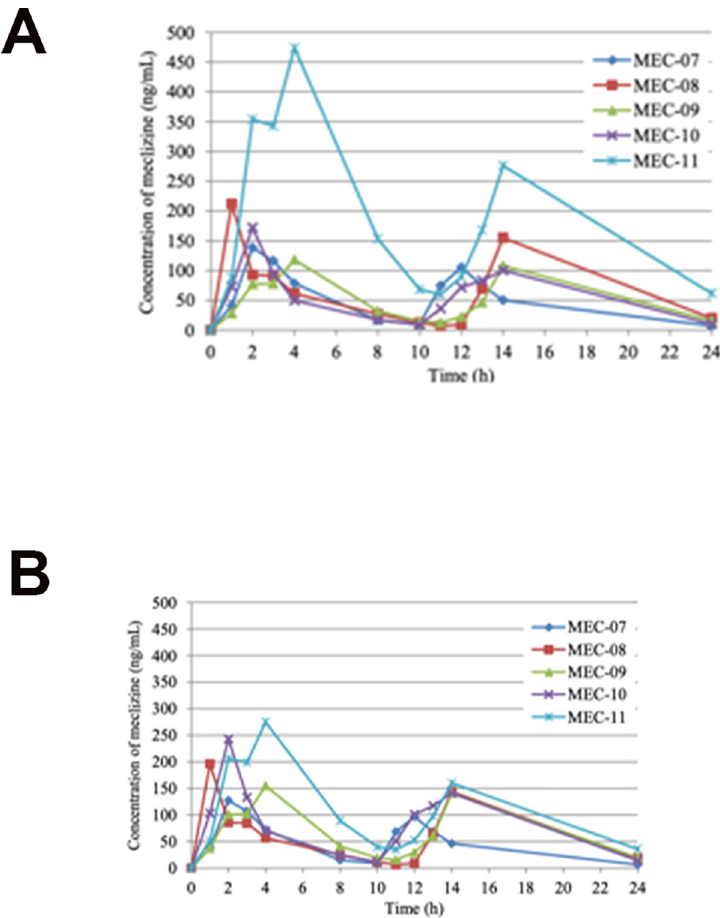
Fig 3. Plasma concentration of meclizine from pre-dosing to 24 hours after twice a day oral administration of meclizine hydrochloride 25 mg tablet. Individual plasma concentration profiles of meclizine in ACH children (A) and body weight normalized profiles by the mean body weight of MEC-01 to MEC-06 (22.9 kg) (B).